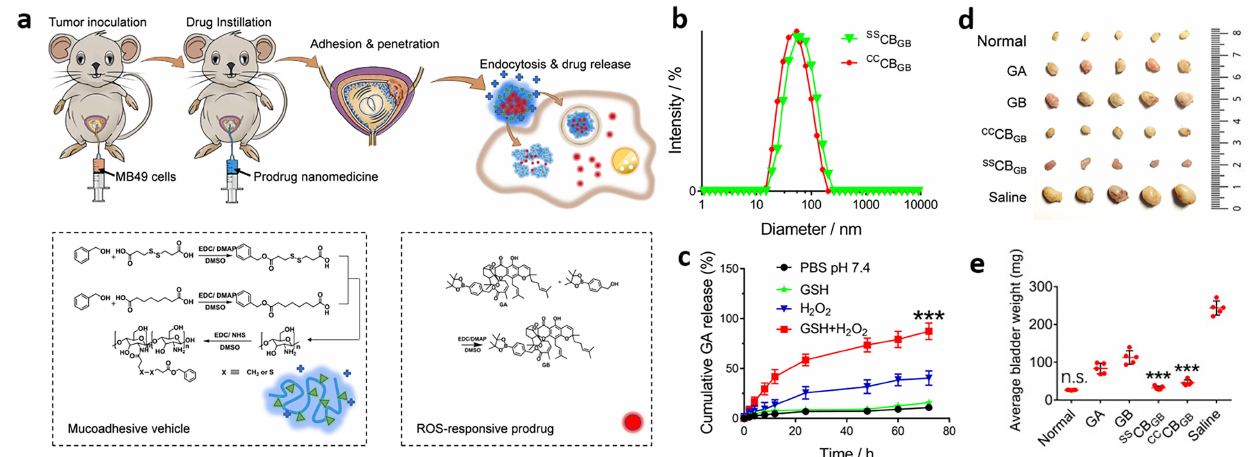
Figure 9. ( a ) The schematic of the intravesical instillation of chitosan-based GSH responsive nanopar- ticles for prodrug delivery reported by Xu et al. ( b ) Rh of SS CB GB and CC CB GB nanoparticles. ( c ) Release profiles of GA from SS CB GB nanoparticles under different environments. *** p < 0.001 for GSH + H 2 O 2 group compared with the other groups. ( d ) The appearance and ( e ) the average weight of normal bladder and saline, GA, GB, SS CB GB and CC CB GB treated bladder. (Reprinted with permission Ref. [109]. Copyright © 2020 Elsevier